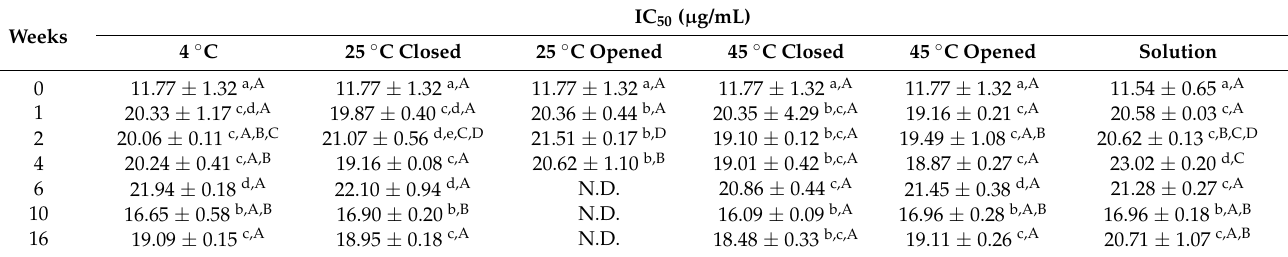
Table 3. Stability in antioxidant activity of the ethanolic extract under various